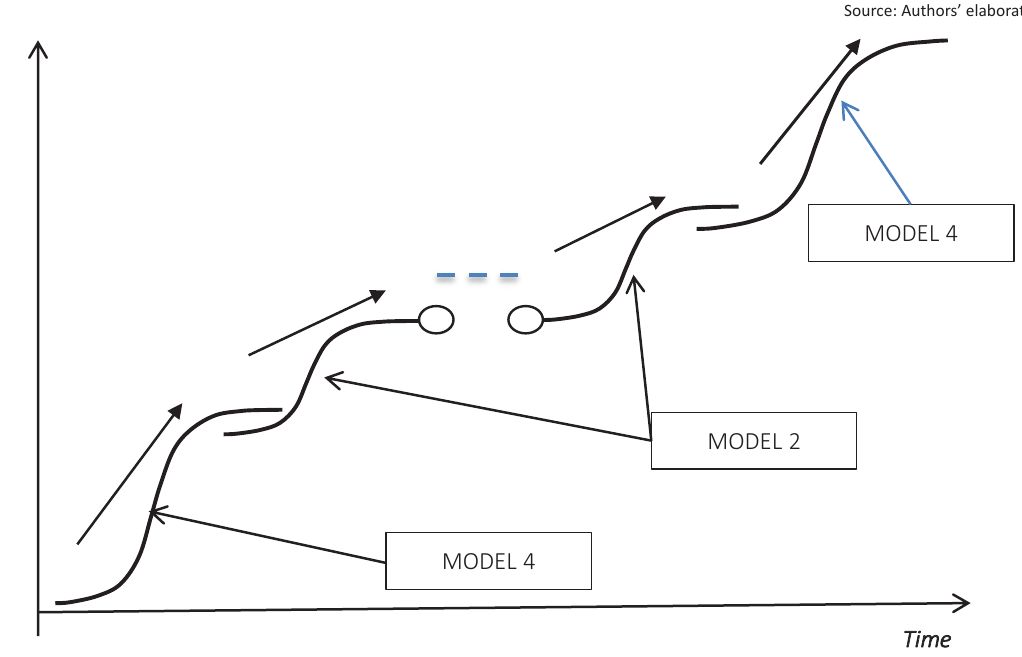
Figure 7. Synergy of innovative models of the second circle of the prognostic